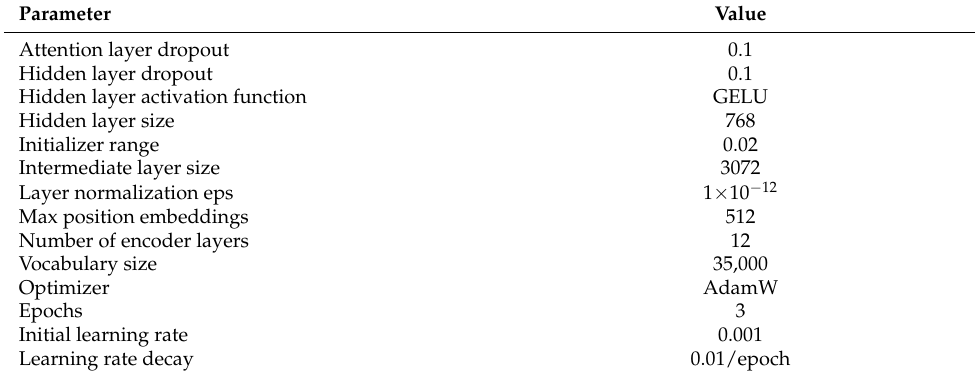
Table A1. Training parameters for the Greek BERT-based DAGB